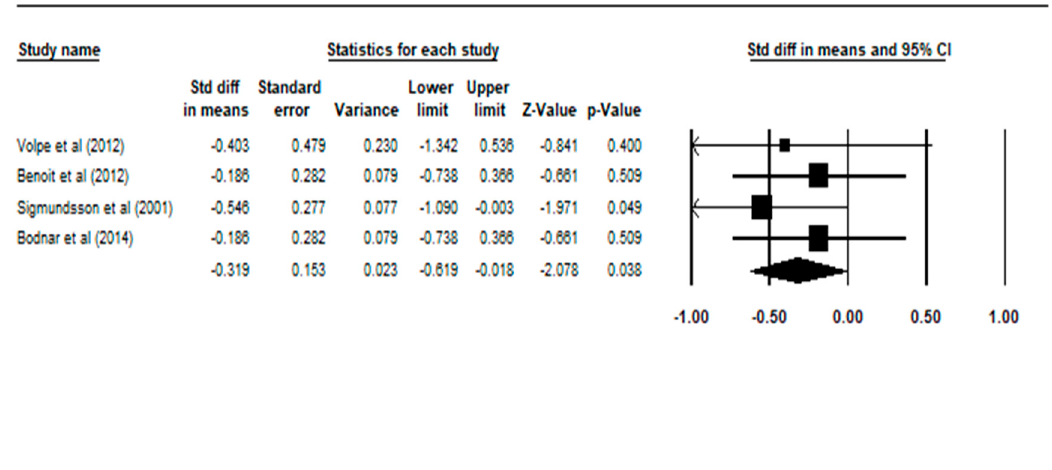
Figure 3. Forest plot: DS vs. HC, white matter volume.